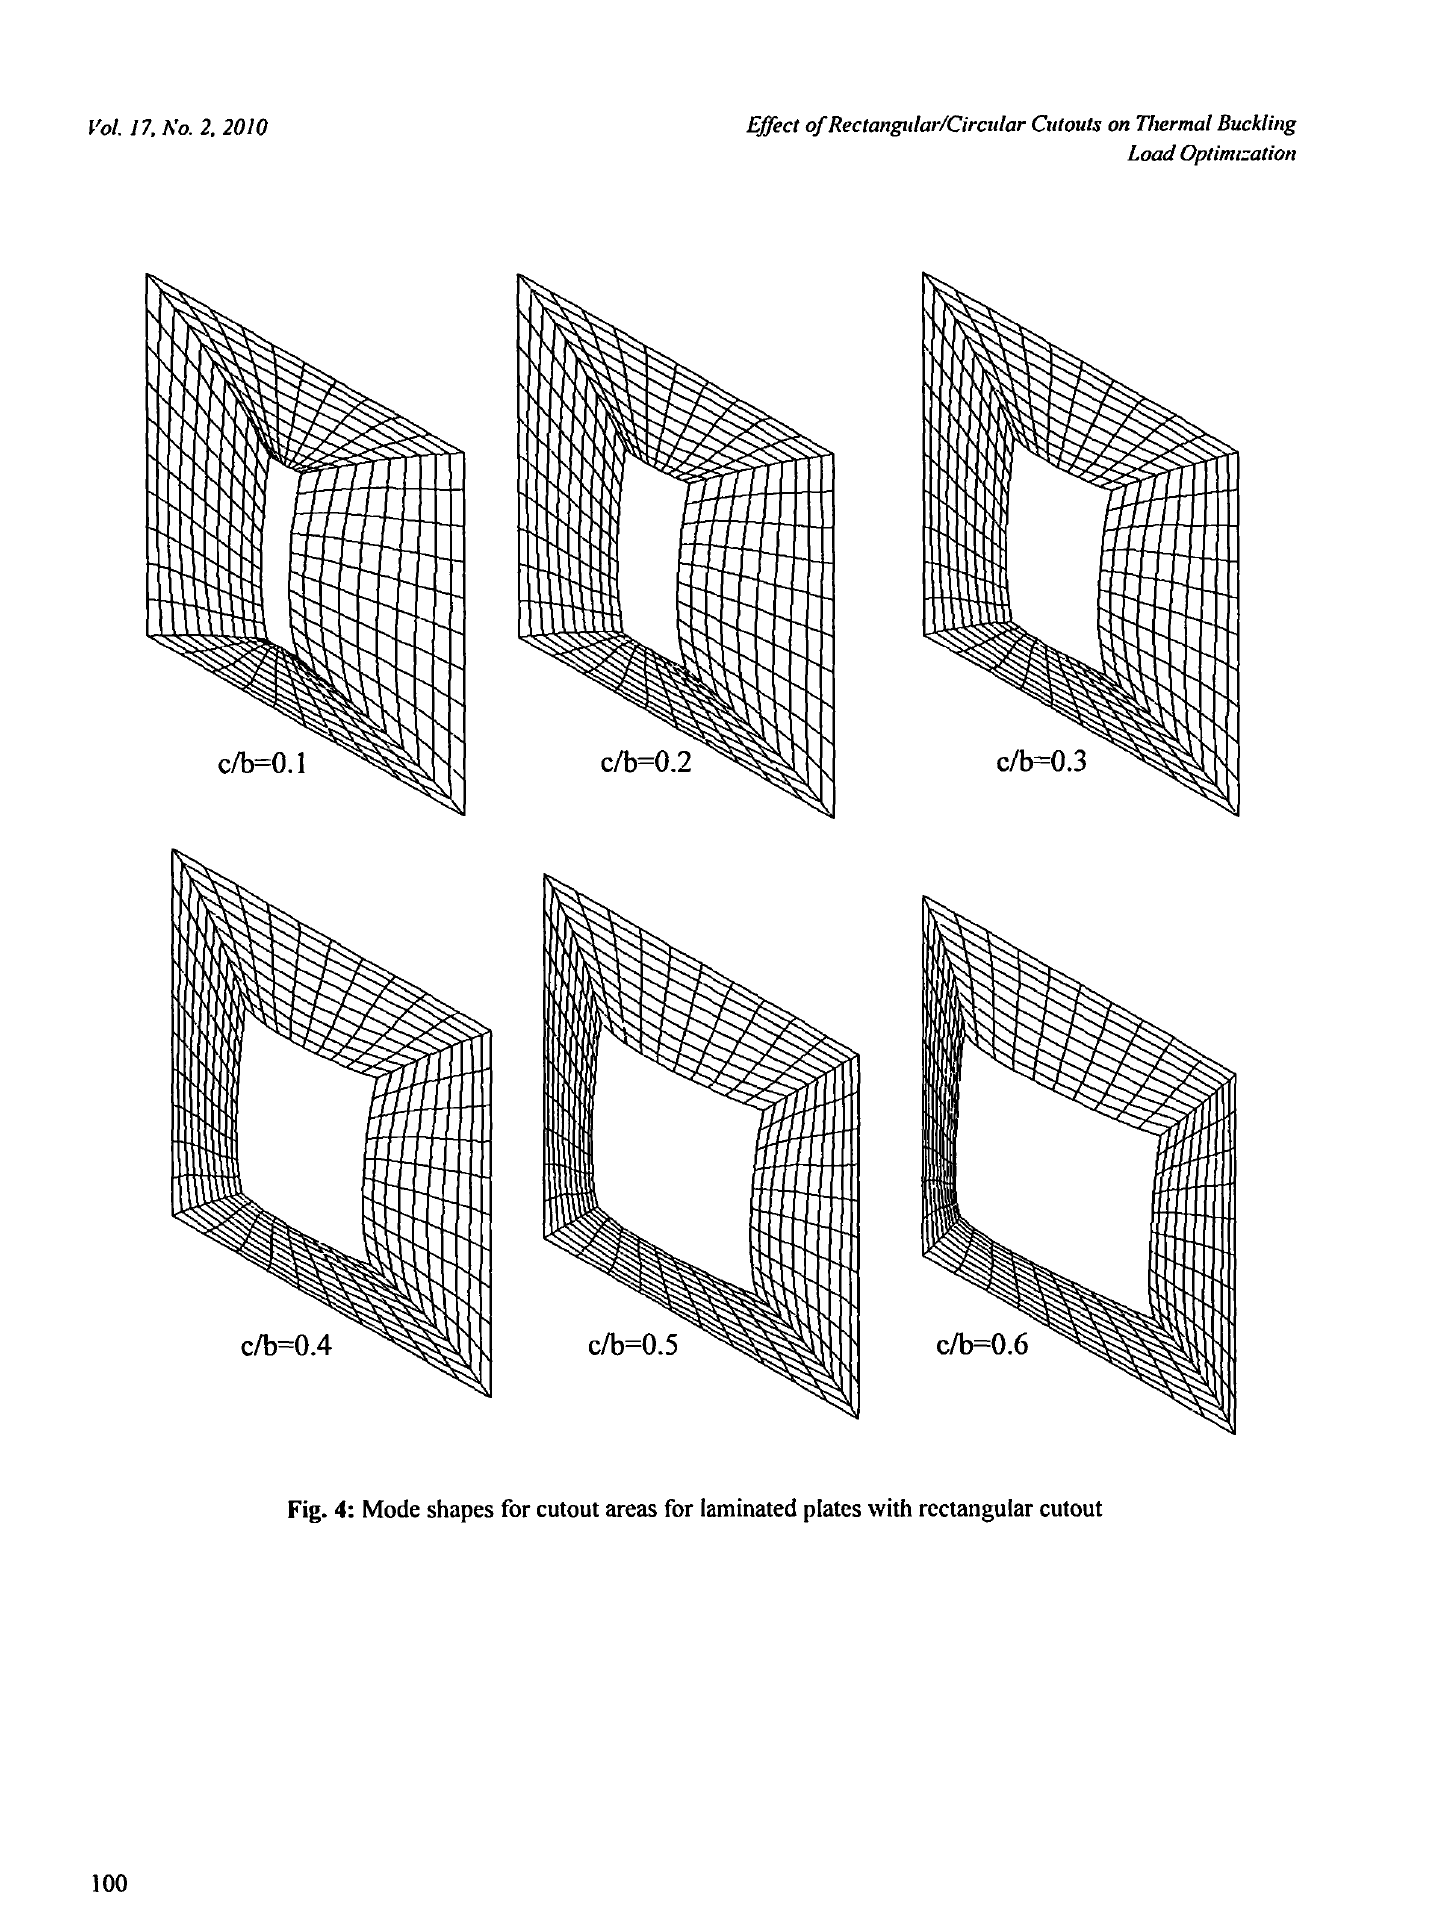
Fig. 4: Mode shapes for cutout areas for laminated plates with rectangular